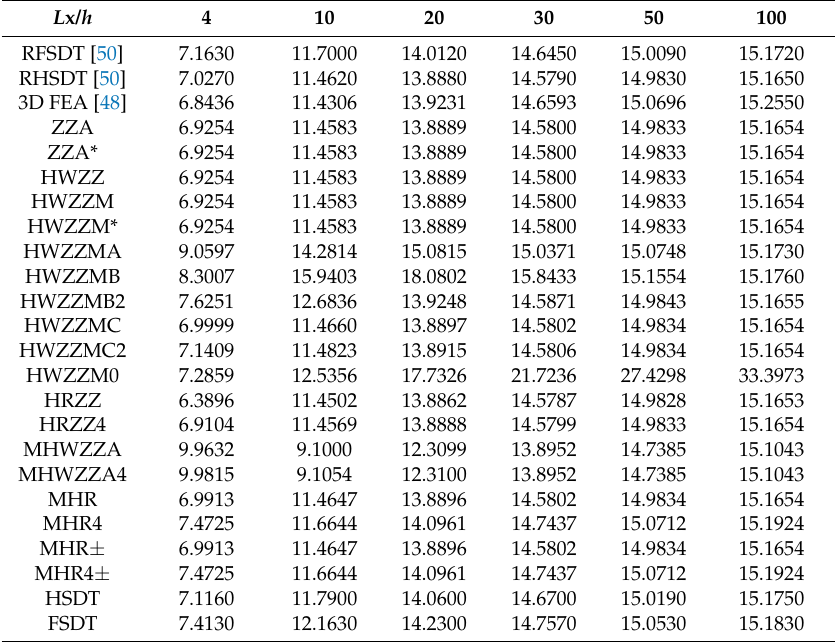
Table 10. Normalized fundamental frequencies, case d1.